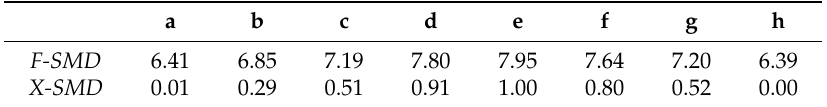
Figure 10. Gray value change trend.